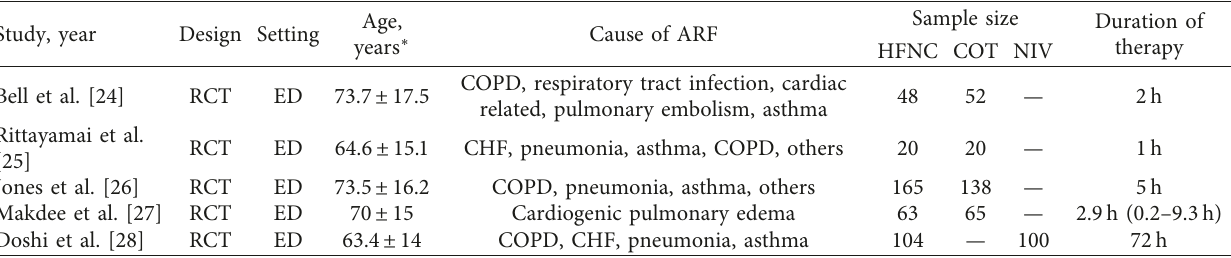
Table 1: The basic characteristics of the included